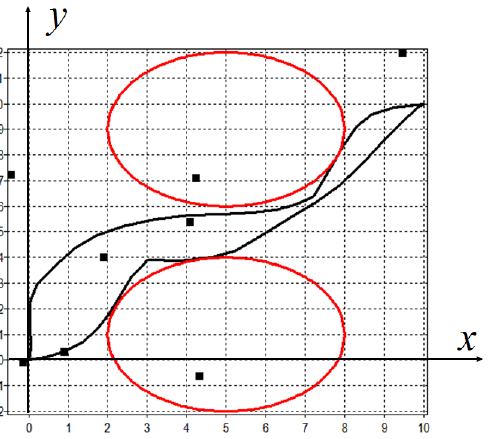
Figure 1. Optimal trajectories of robots on the plane { x , y } for synthesized optimal control. The quality criterion (70) for found control was J e =